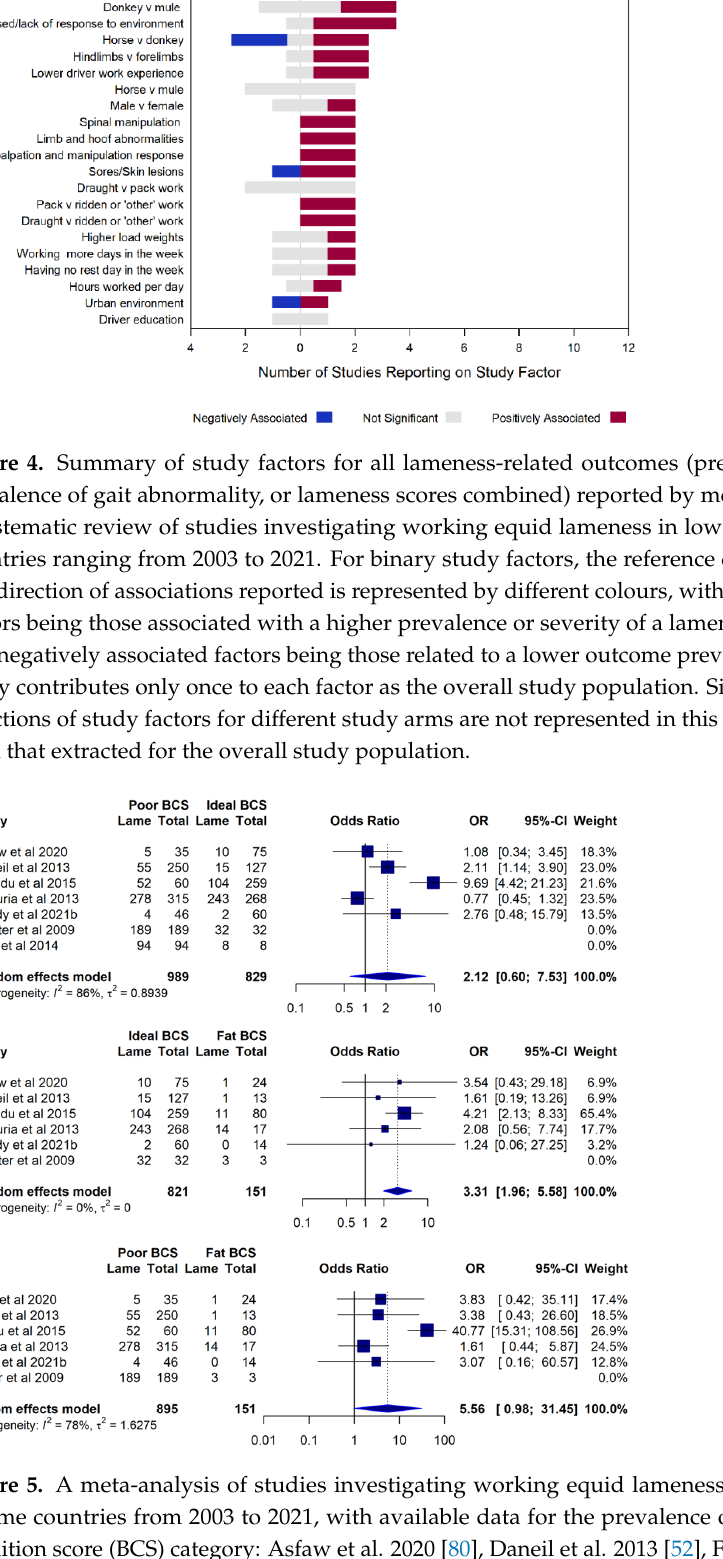
Figure 6. A meta-analysis of studies investigating working equid lameness in low- and middle-in- come countries ranging from 2003 to 2021, with available data for the prevalence of lameness ac- cording to number of days worked per week: Solomon et al. 2019 [47], Fekadu et al. 2015 [49], Ba- zezew et al. 2014 [16], Haddy et al. 2021b [34]. The reference category is listed on the right. 3.8. Studies Included for Qualitative Assessment Only Seventeen percent of studies (11/64) investigated lameness-related outcomes in working equids but were included in qualitative synthesis [ 81 – 90 ] (Spreadsheet S4). These studies were not eligible for data extraction, as the sampled population had other concur- rent abnormalities (3/11; 27.3%), investigated populations of exclusively lame animals